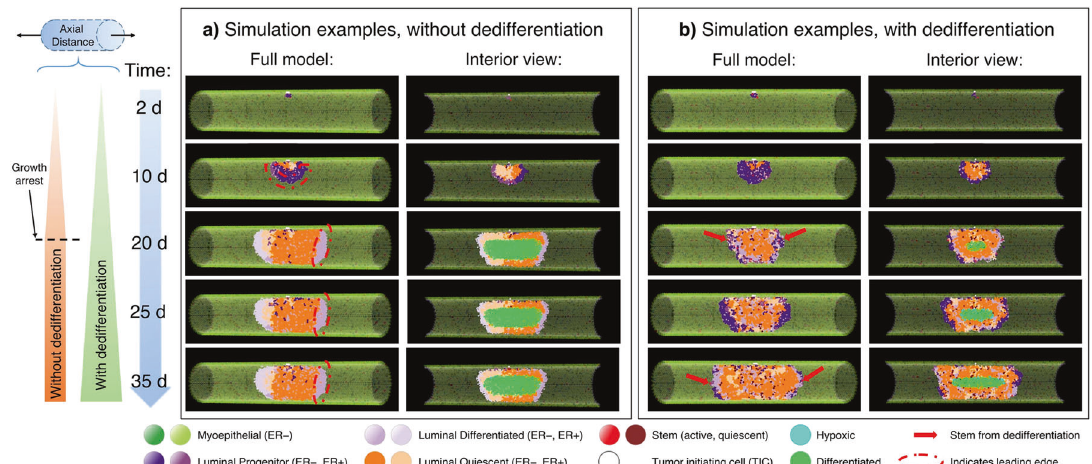
Fig. 3 Representative model simulations. a Representative model states rendered from a simulation without dedifferentiation are shown as full simulated duct (left) and cross-sectional view (right; cross-section taken along y = 0 plane). DCIS is initiated at the top-center of the duct by 5 TIC cells (white) at t = 0 days (d); daughters are placed adjacently into the luminal cavity, and DCIS grows away from site of initiation along the leading edge (examples are indicated by red dashed curves). In the example shown, the leading edge has become terminally differentiated at time t = 20 days (d), and growth arrest is observed as only minimal further expansion of the DCIS mass occurs after this time. Calci fi cation due to hypoxia is observed (green agents) in the cross-sectional view (right column). b Representative model images from a simulation with the dedifferentiation pathway activated. At time t = 20 days (d), dedifferentiated cells (lighter purples) are again observed in the leading edge, but in this case new stem cells (red arrows) have emerged in the leading edge; this behavior is again observed in times t = 25 days and t = 35